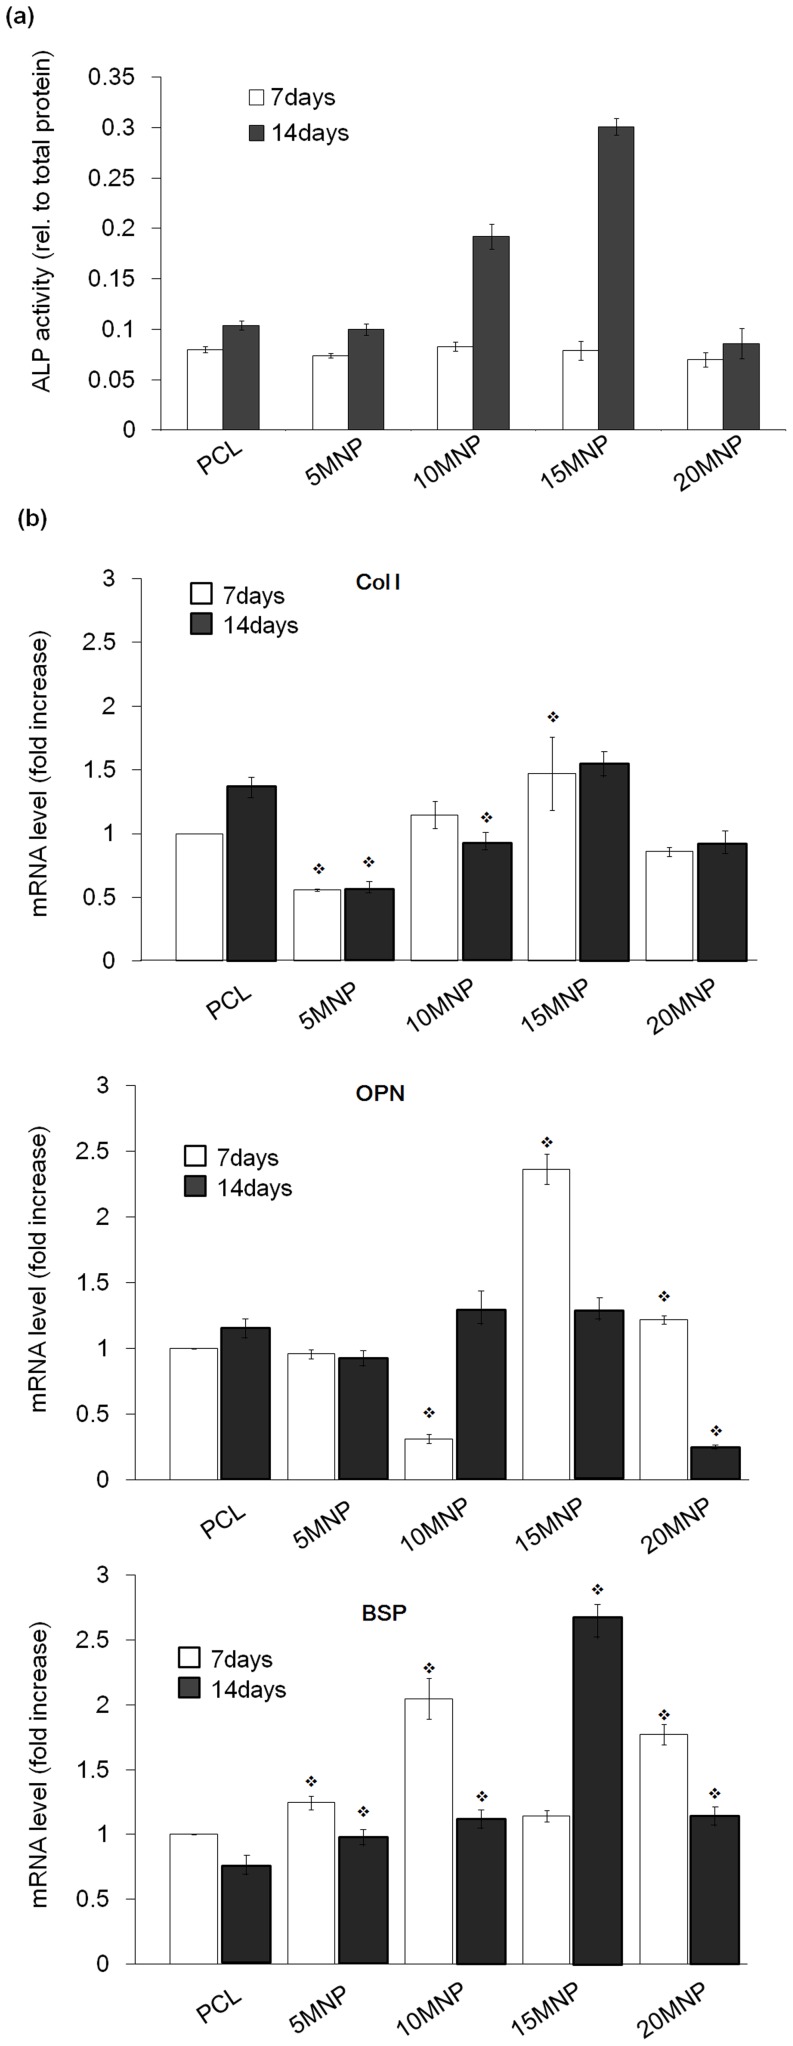
Osteogenic differentiation of cells during culturing on the nanofiber scaffolds for 7 and 14 days.Differentiation was assessed by (a) ALP activity and (b) quantitative RT-PCR, where the mRNA expression of bone-associated genes (Col I, OPN and BSP) was compared between groups.